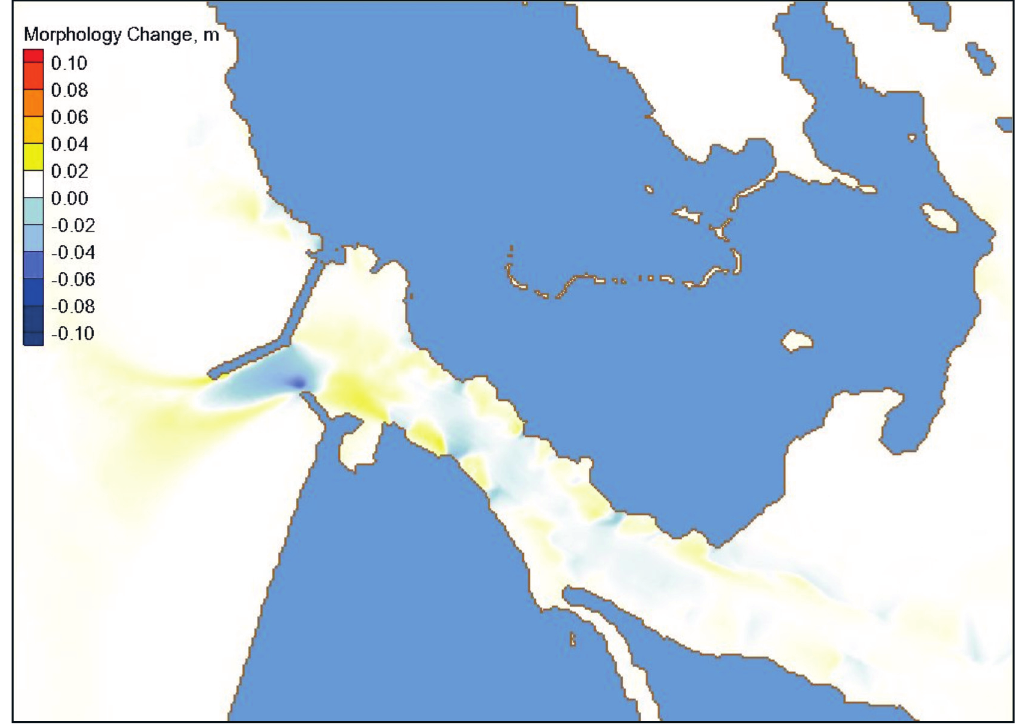
Figure 33. Calculated sediment accretion and erosion field for Alt 4 under Hurricane